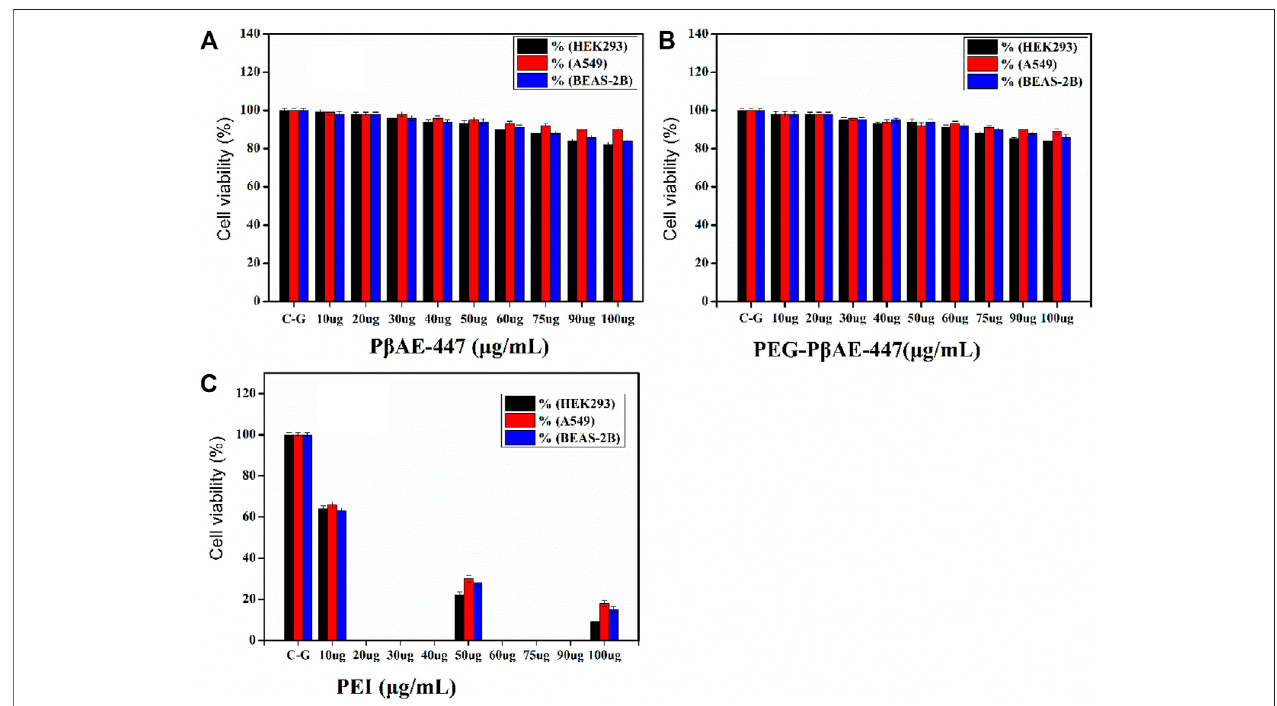
FIGURE 5 | Cell viability assay for pure and PEGYlated P β AE-447 at various concentrations towards HEK-293, BEAS-2B, and A549 cells. PEI (25 kDa) was used as a control (n = 3; and error bars represent standard deviation).